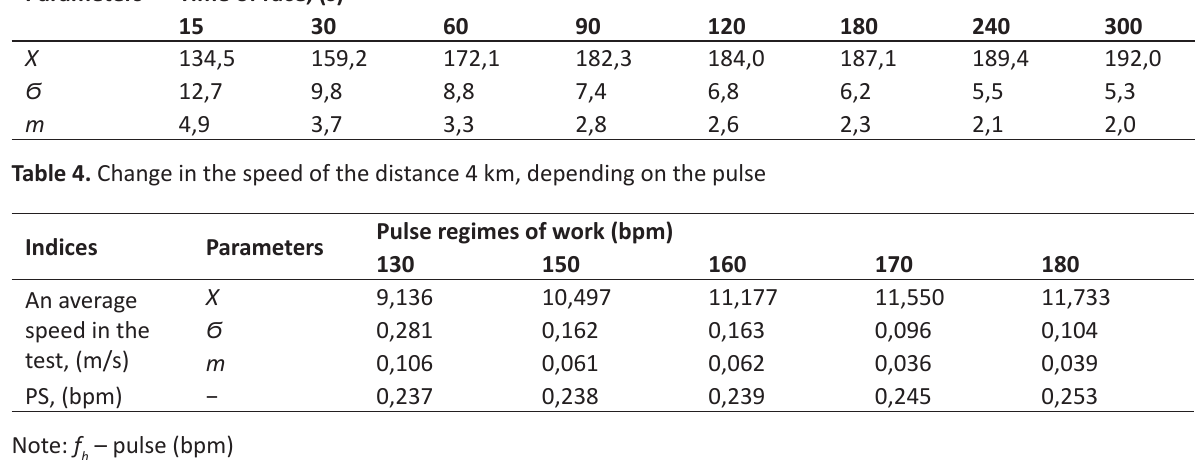
Table 3. Change in the value of the pulse (fh) of cyclists during an individual pursuit race at 4 km Parameters